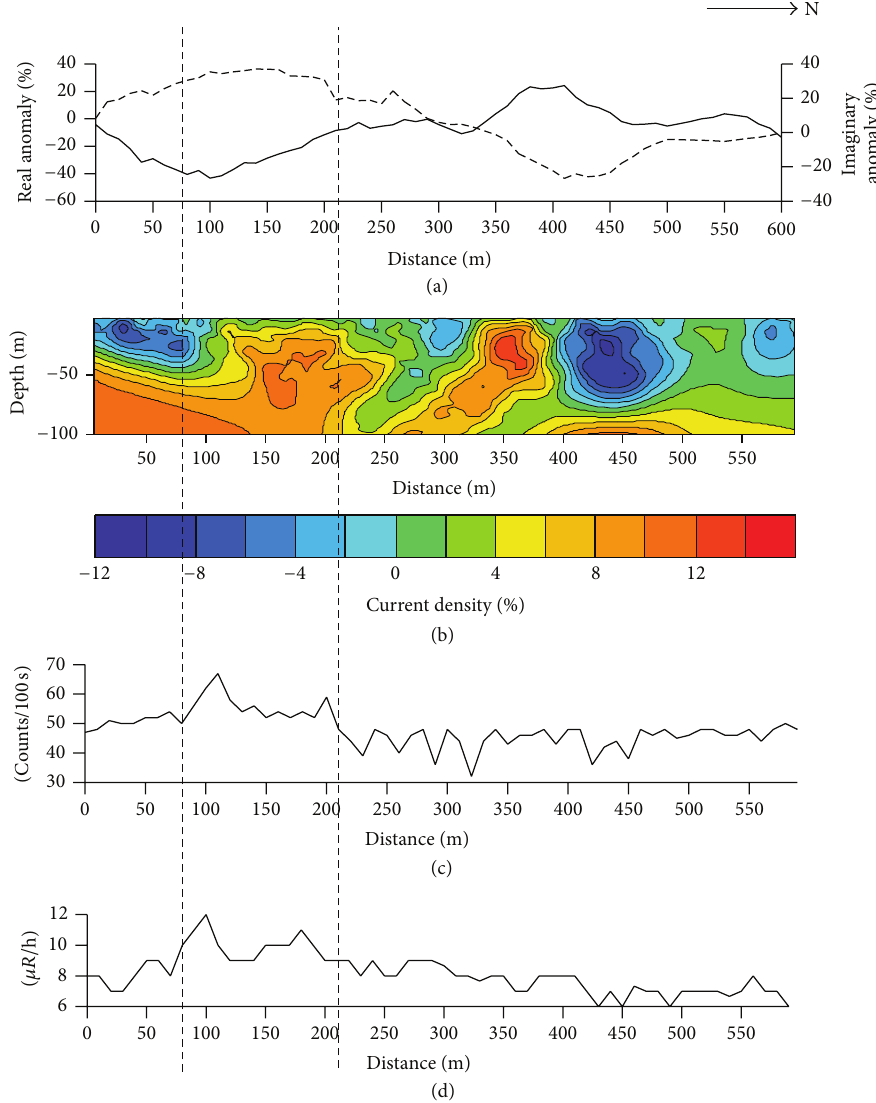
Figure 8: Profile P1700: (a) VLF anomaly (real by solid line and imaginary by dashed line), (b) pseudo current density cross-section along profile P1100, and (c) surface radiation and (d) surface gamma